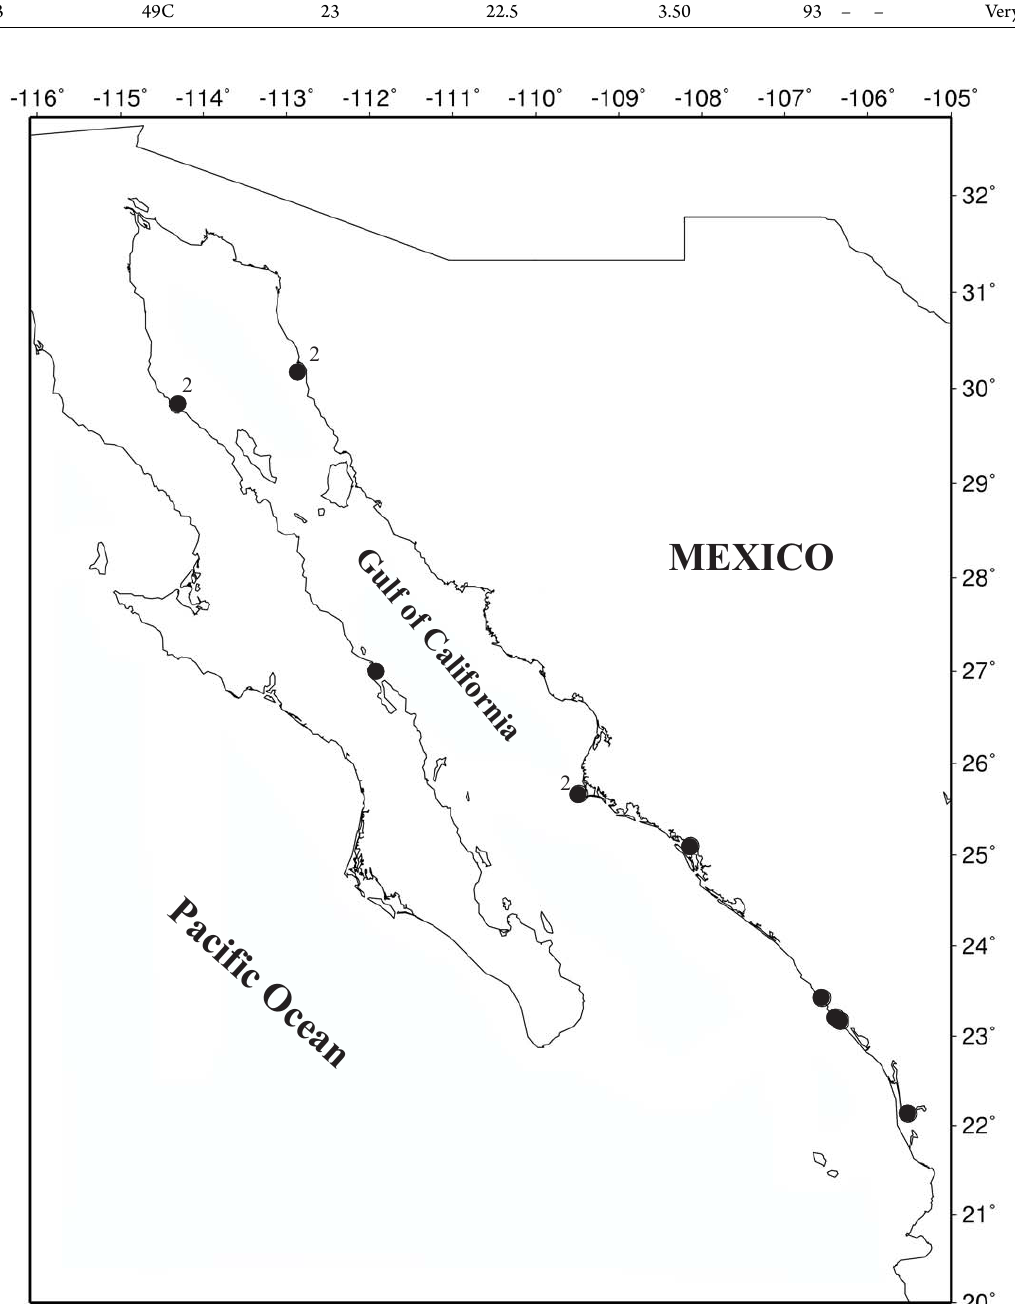
Figure 4. Localities in the Gulf of California where Malacoplax californiensis was found. Number 2 indicates that two samples were collected at very close